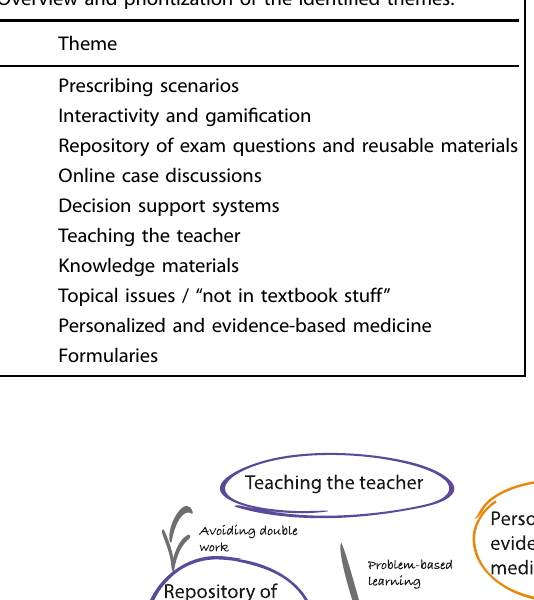
Table 3. Overview and prioritization of the identi fi ed themes.